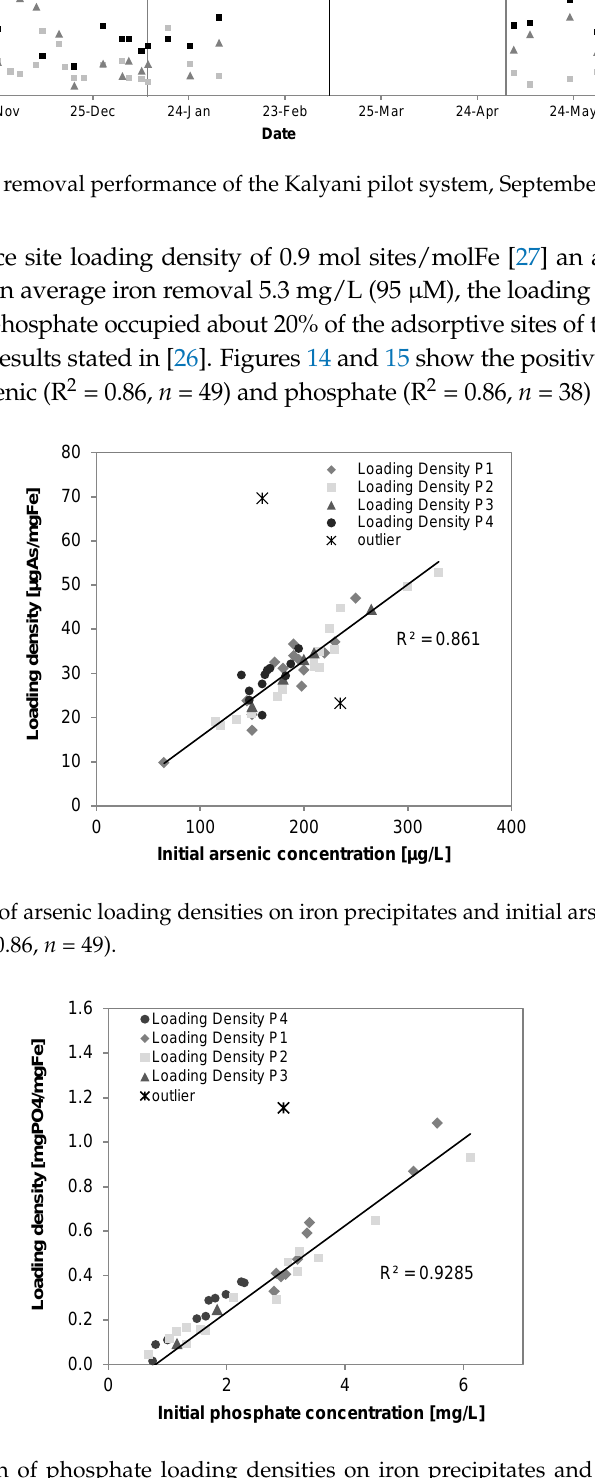
Figure 16. Arsenic removal in relation to phosphate loading density A summary of the water quality parameters analyzed during P1–P4 is given in Table A1. 3.7. Energy Demand In Table 6 the power and energy demands for the system operation are given. Table 6. Energy requirements for water treatment (as in P2 and P4). Consumer